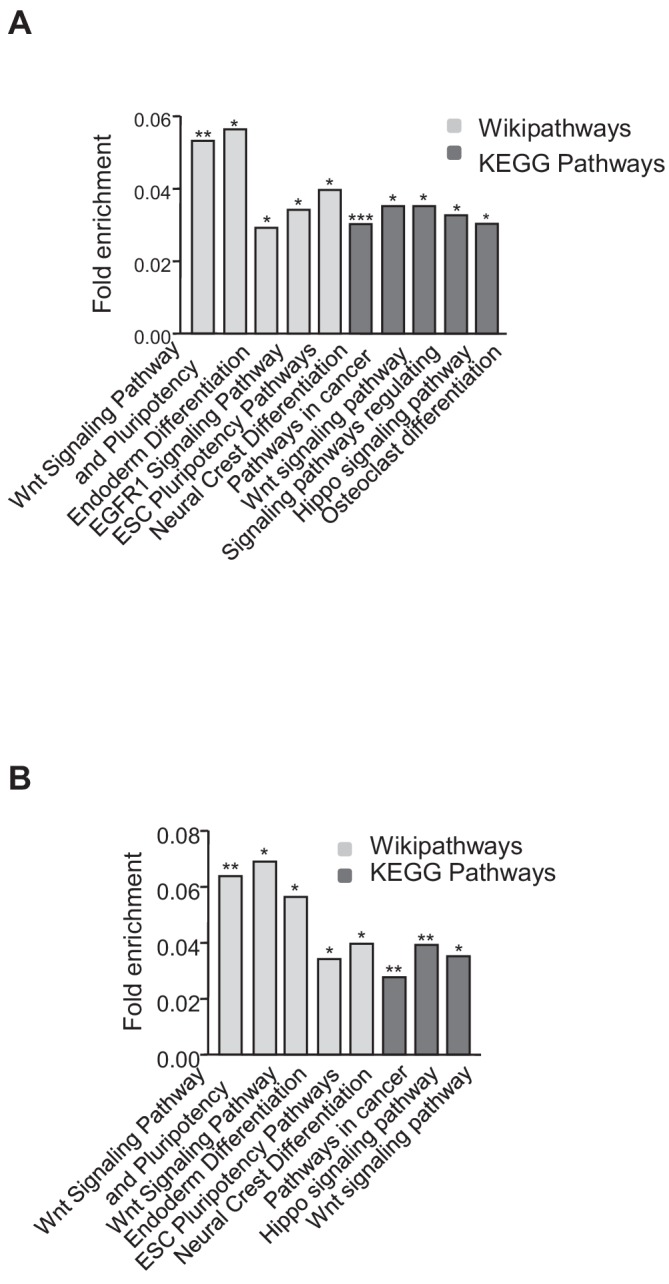
Functional analysis of genes that are upregulated in the absence of TRF1 and that show recruitment of SUZ12 and H3K27me3.(A) KEGG and Wikipathways analysis of genes that are upregulated in the absence of TRF1 that show recruitment of SUZ12. The histogram shows that these genes are significantly enriched in important pathways controlling pluripotency and differentiation. (B) KEGG and Wikipathways analysis of genes that are upregulated in the absence of TRF1 and that show recruitment of H3K27me3 . The histogram shows that these genes are significantly enriched in important pathways controlling pluripotency and differentiation.